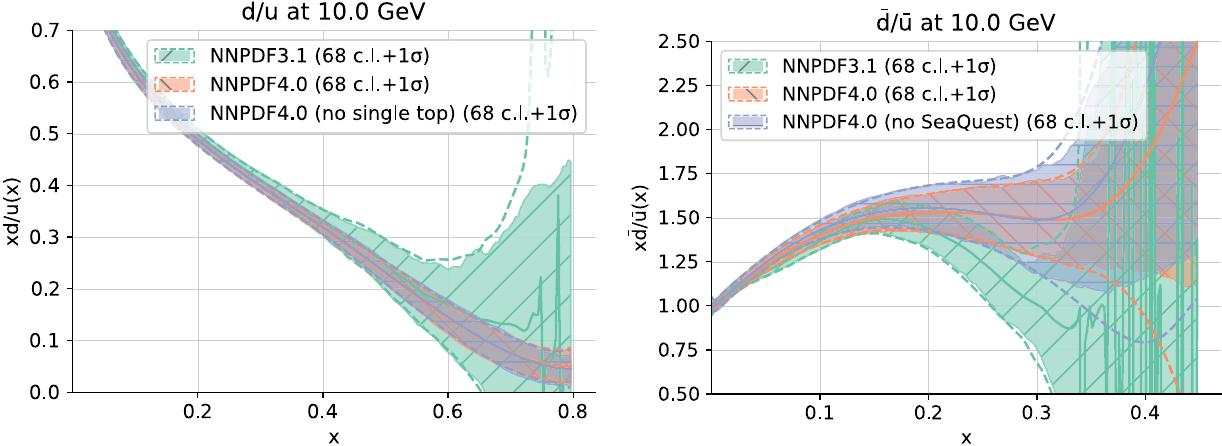
Fig. 36 The d / u (left) and ¯ d / ¯ u (right) ratios, at Q = 10 GeV, computed, respectively, from a NNPDF4.0 fit without single top-quark data or without SeaQuest data. In both cases we show results obtained with the NNPDF3.1 and NNPDF4.0 baseline